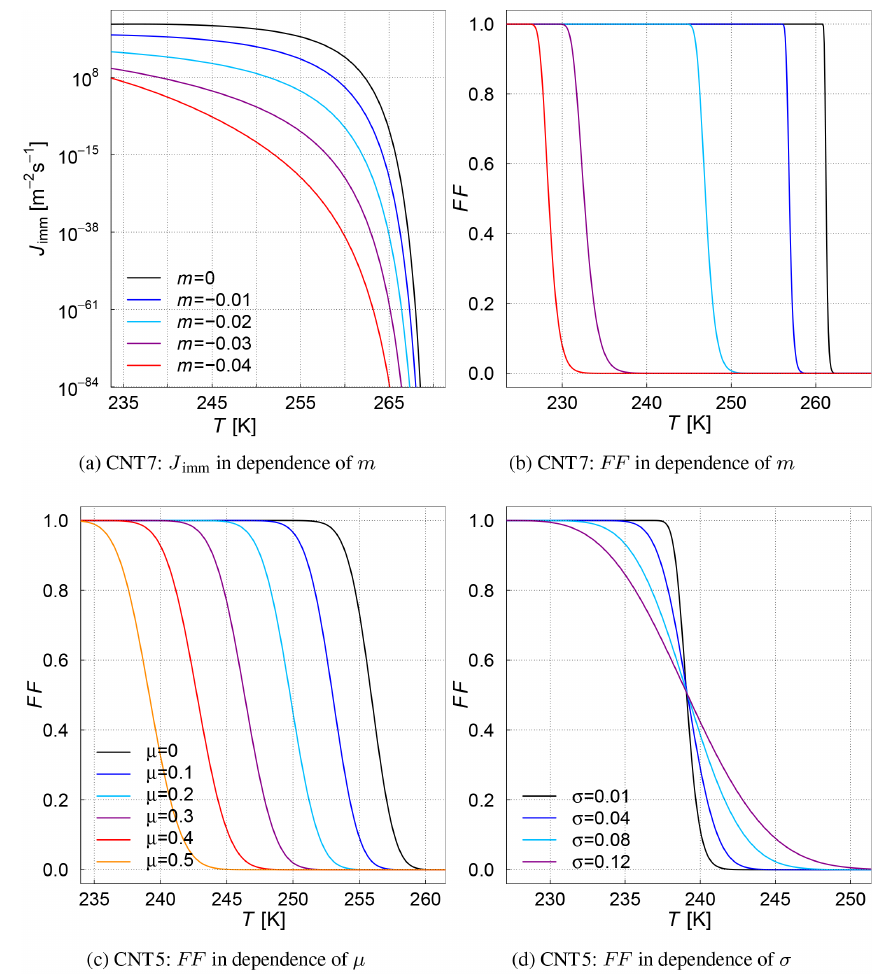
Figure A2. Nucleation rate J imm and frozen fraction FF in dependence of the fit parameters for the contact angle schemes 7 and 5 ( m , µ , and σ ). To estimate FF we assume a aerosol particle diameter of 400nm and a timestep of 10s. In case of CNT7 α 0 was chosen to be 0.8 ( ≈ 46 ◦ ). Note that the dependence of the scheme on α 0 (in the case of a fixed change in contact angle m ) is the same as the change with f of the single- α R&D + Z formulation (CNT1). In case of the α -pdf R&D + Z formulation (CNT5) σ was chosen to be 0.05 in the left figure and µ was chosen to be 0.5 ( ≈ 29 ◦ ) in the right figure. Decreasing m (increasing contact angle with decreasing T because a broader part of the IN populations contact angle distribution causes nucleation) shifts the freezing curve to lower temperatures and changes the slope of the curve (flattening). Increasing µ (increasing the average contact angle) shifts the freezing curve to lower temperatures and slightly flattens the curve, while an increase in σ (broadening of the contact angle distribution) changes the slope of the freezing curve only (flattening). Note that already small changes in µ lead to a considerable shift of the curve compared to the other